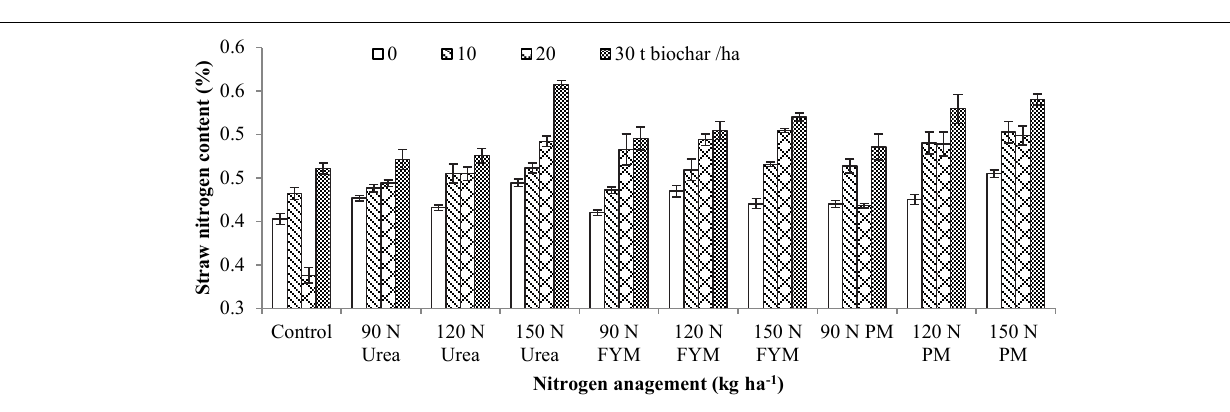
between BC and N was also significant for GPC.